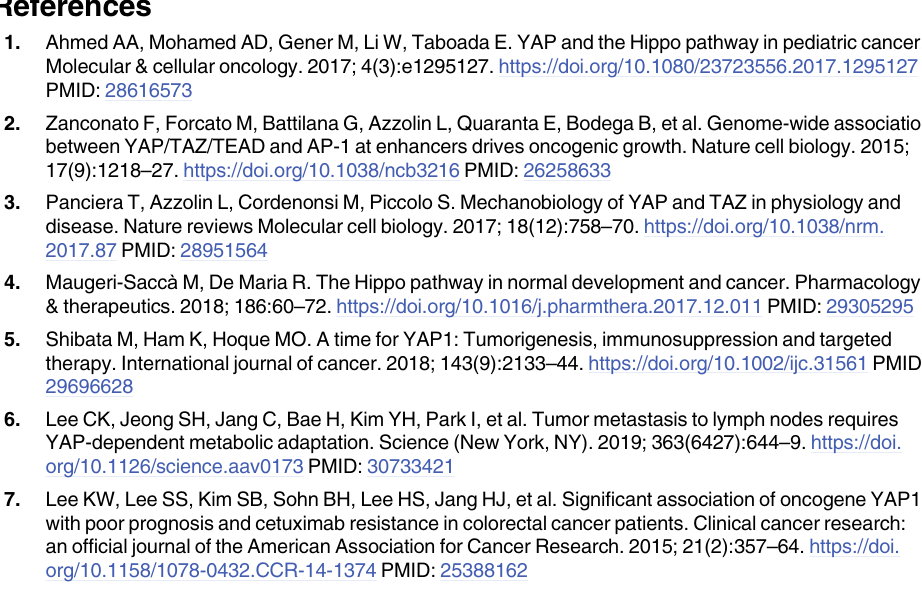
S1 Table. Relationship between p53 expression pattern and mutation